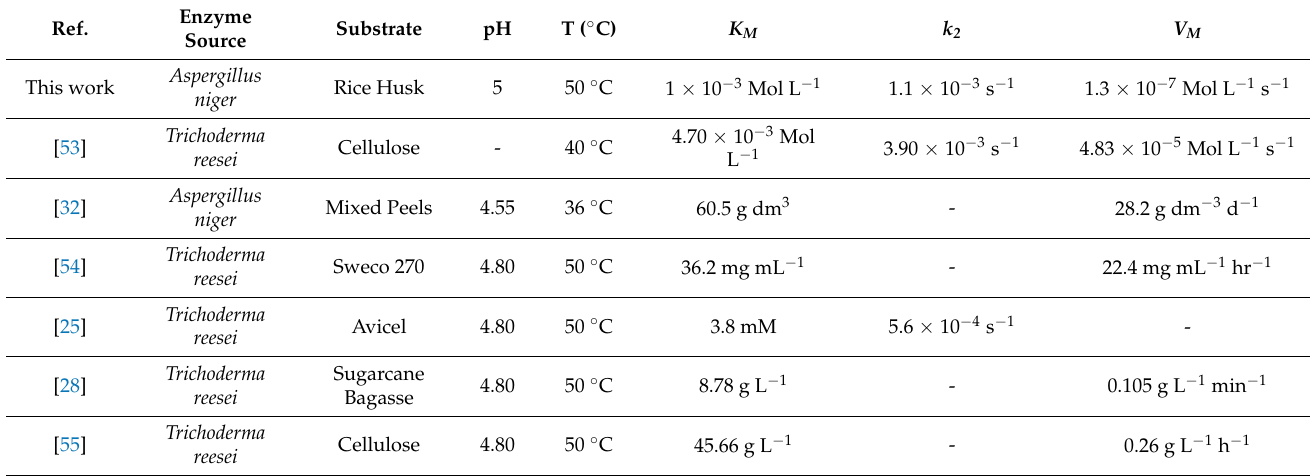
Table 4. Cellulose enzymatic hydrolysis kinetic constants proposed by various authors. Ref.